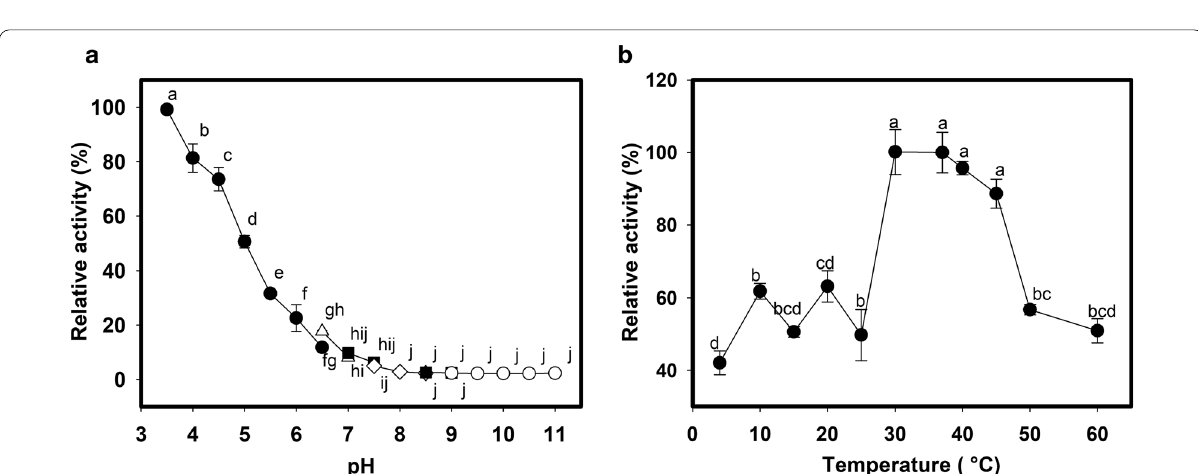
Fig. 3 Effects of pH and temperature on LacMeta activity. a Effect of pH on laccase activity. The buffers used were: 20 mM sodium citrate (pH 3.5 to 6.5) (black circle), 20 mM sodium phosphate (pH 6.5 to 7.0) (white triangle); 20 mM TRIS–HCl (pH 7.0 to 7.5 and 8.5 to 9.0) (black square), 20 mM HEPES (pH 7.5 to 8.5) (white rhombus) and sodium bicarbonate at 20 mM (9.0 to 11) (white circle). b Effect of temperature on activity. An enzymatic activity was measured from 4 to 60 °C in 20 mM sodium citrate buffer (pH 4.0). The tests were performed with 3 replicates. The values followed by the same letter do not differ statistically, according to the ANOVA and Tukey test, with a 5%